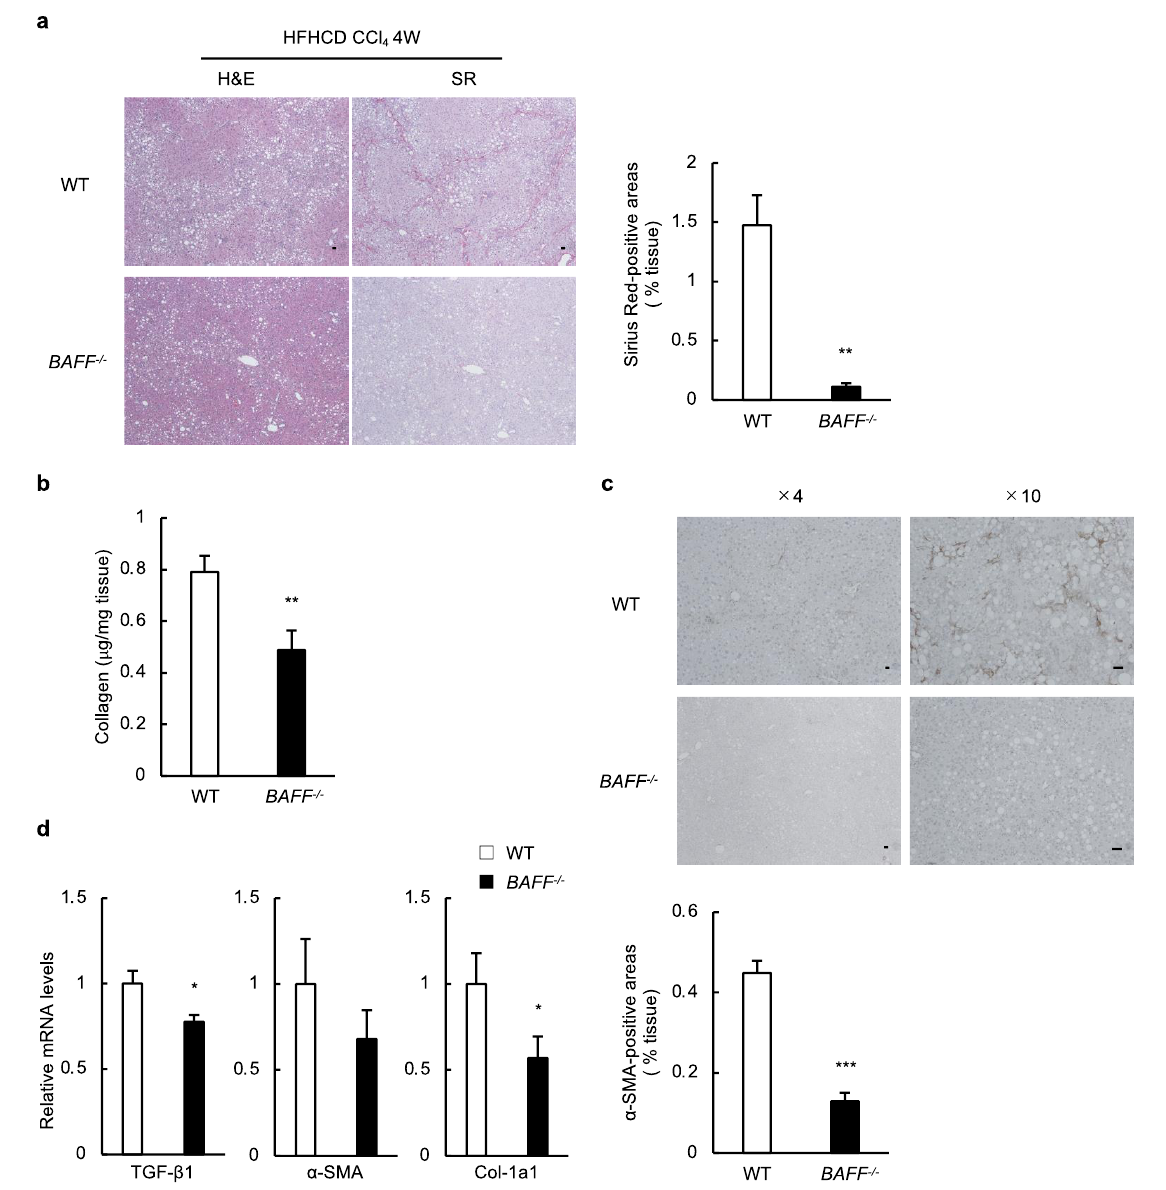
Figure 3. BAFF-deficient mice are protected from the development of NASH and the progression of liver fibrosis. ( a ) Representative H&E and SR staining (left) and quantification of SR-positive area (right) in livers from WT and BAFF − / − mice treated with HFHCD/CCl 4 (scale bar, 100 µ m; images from seven different fields; n = 7/group); ( b ) Total collagen content in the liver was determined using the hydroxyproline assay from HFHCD/CCl 4 -treated mice ( n = 10/group); ( c ) Representative α -SMA staining (upper) and quantification of α -SMA-positive area of the livers (lower) of HFHCD/CCl 4 - treated mice (scale bar, 100 µ m; images from seven different fields; n = 8/group); ( d ) Expression of genes related to fibrosis in the livers of HFHCD/CCl 4 -treated mice ( n = 9/group). For all bar plots shown, data represent mean ± standard error of the mean. * p < 0.05, ** p < 0.01, and *** p < 0.001. BAFF, B cell-activating factor; NASH, non-alcoholic steatohepatitis; H&E, hematoxylin, and eosin; SR, Sirius red; WT, wild-type; HFHCD, high-fat/high-cholesterol diet; W, weeks; α -SMA, α -smooth muscle actin; TGF, transforming growth factor; Col, collagen.